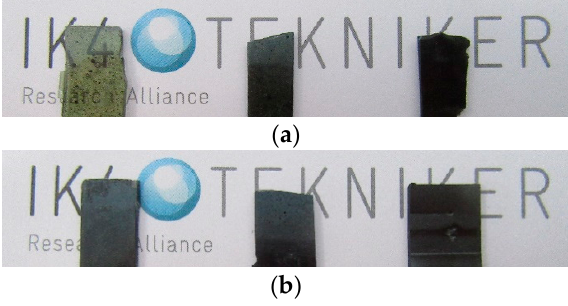
Figure 9. Final appearance of composites with 0.5, 2, and 5 wt % of: ( a ) GO and ( b ) rGO.